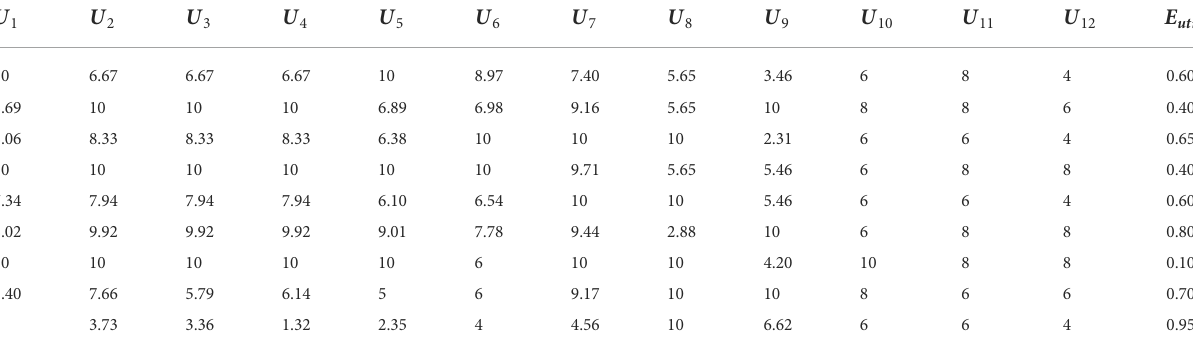
TABLE 2 Learning samples of each indicator and utility scores based on previous engineering case.